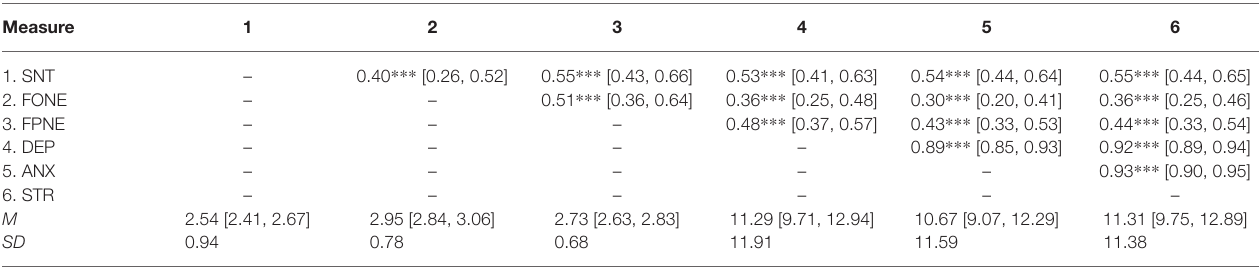
TABLE 1 | Descriptive statistics and Pearson correlations for perceptions of having transgressed a social norm (SNT), fear of own negative evaluation (FONE), fear of parental negative evaluation (FPNE), depression (DEP), anxiety (ANX), and stress (STR) for the South Asian group, with bootstrapped 95% confidence intervals based on 10,000 bootstrap